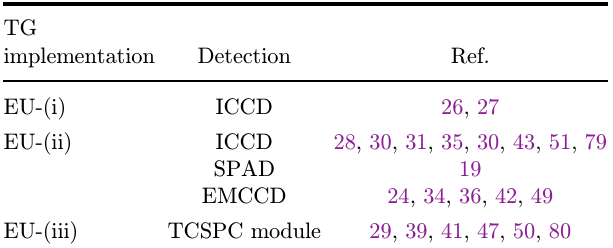
Table 4. Summary of TG implementation based on electronic units.